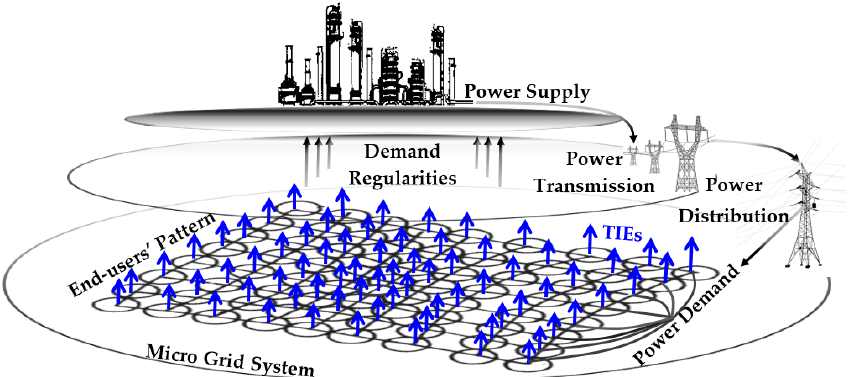
Figure 1. Electrical Smart Grid Complex Systems.